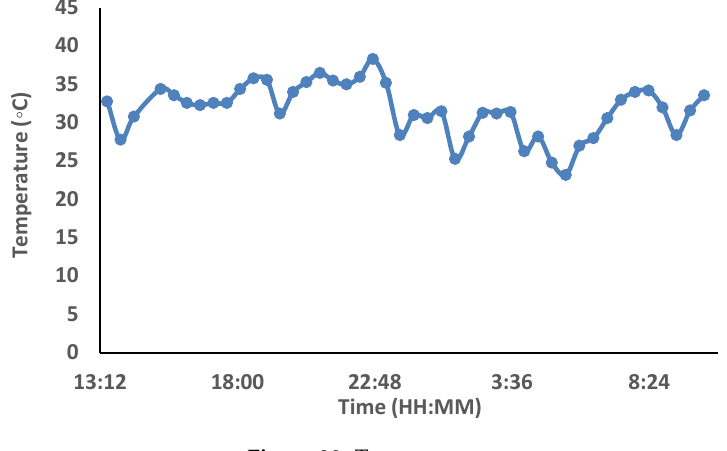
Figure 20. Temperature. Figure 20.